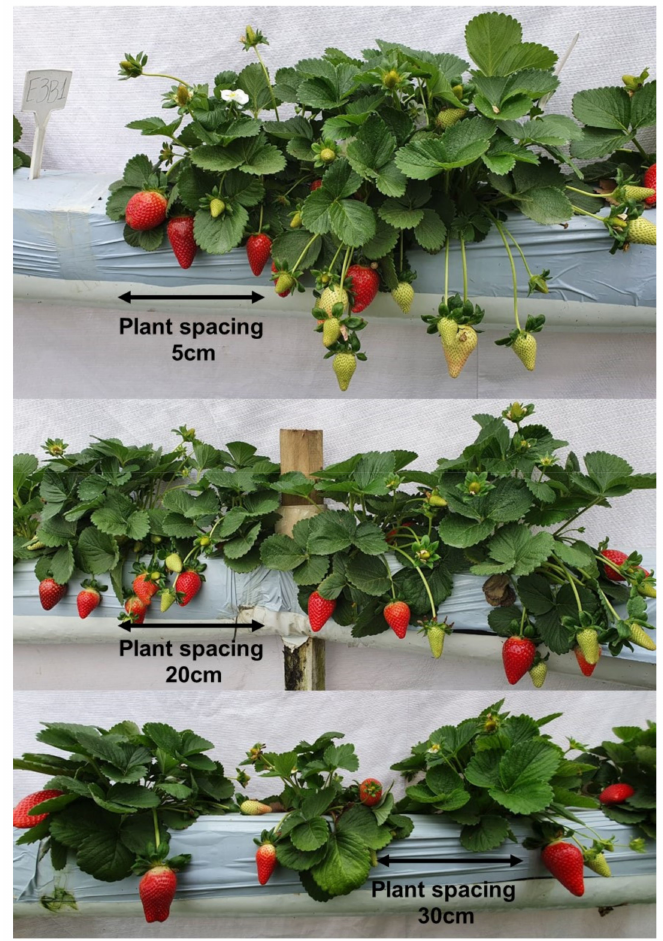
Figure 1. Strawberry plants from the cultivar Pircinque, in different spacing in your cultivation structure (25 × 20 cm) in the first cicle